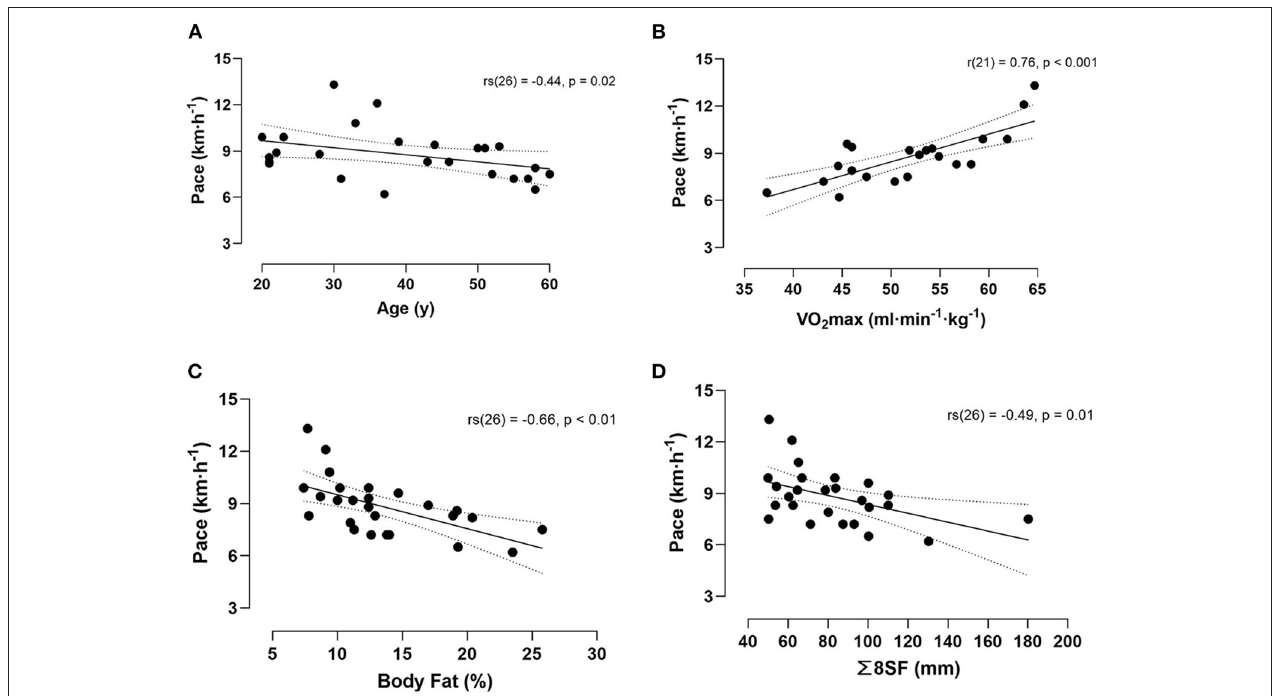
FIGURE 3 | Correlation between the running performance and age (A) , VO 2 max (B) , body fat percentage (C) and sum of eight skinfolds (D) . Dotted lines denote 95% CI.